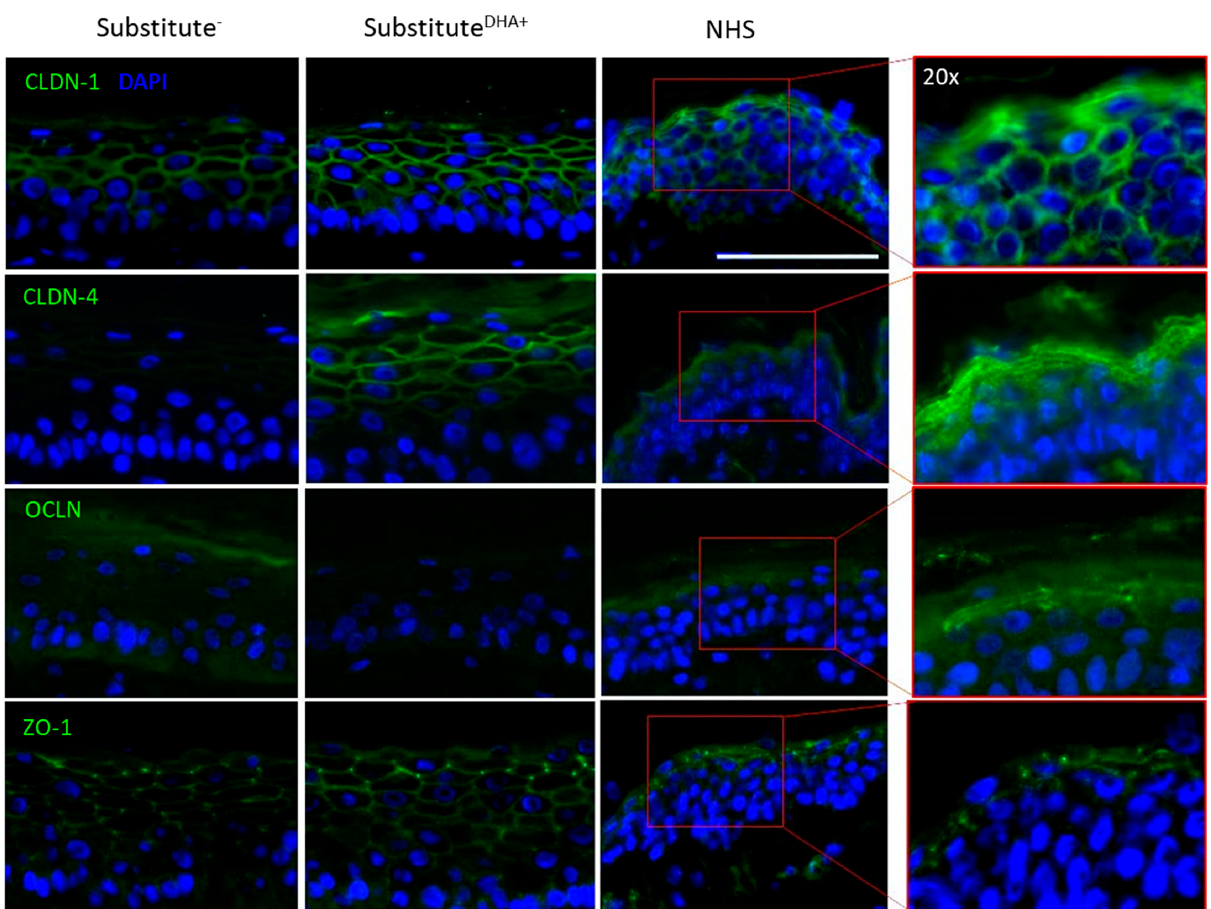
Figure 4. Expression of TJ proteins in the epidermis of skin substitutes. Immunofluorescence analyses were used to observe TJ protein expression patterns in the epidermis of skin substitutes. Cldn-1, -4, Ocln, and ZO-1 were stained in green and the nuclei were stained in blue with DAPI. Scale bars: 100 μ m. N = 3 (3 donors, 2 skin substitutes per donor). Abbreviations: Cldn-1, claudin-1; Cldn-4, claudin-4; NHS, normal human skin; Ocln, occludin; ZO-1, tight junction protein-1.